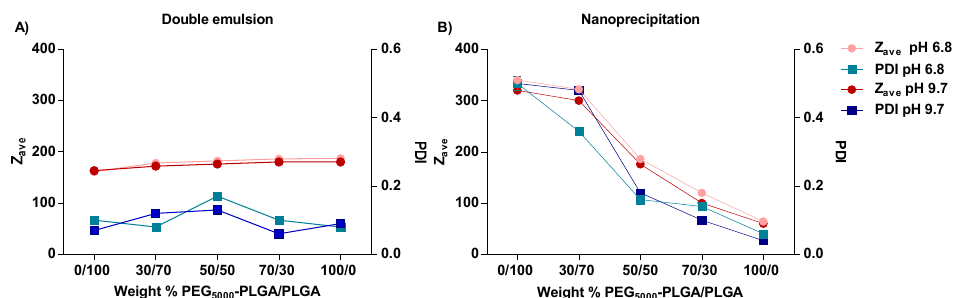
Figure 3. Z-average hydrodynamic diameter (Z ave ) and polydispersity index (PDI) of FS10-loaded nanoparticles prepared by double emulsion ( A ), and nanoprecipitation method ( B ) at pH 6.8 and 9.7. All measurements were performed in triplicate (n = 3) for every single batch.